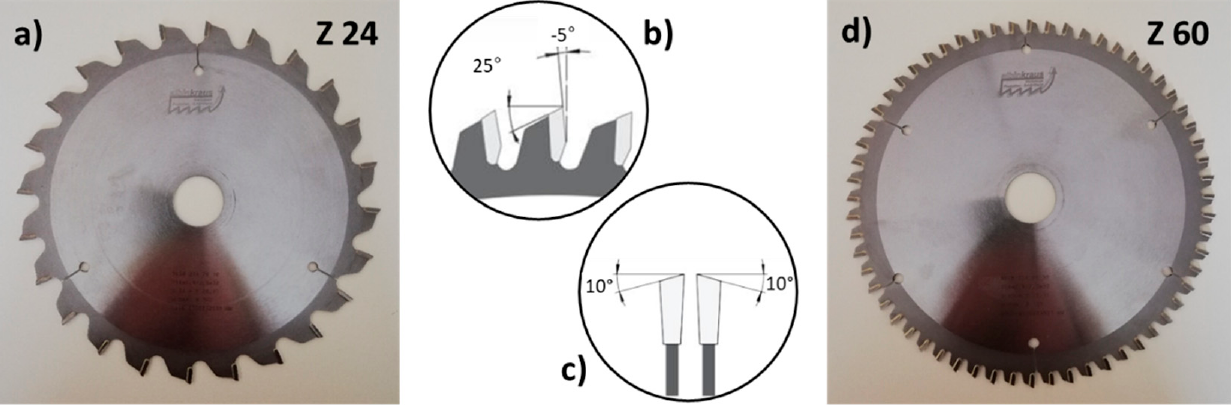
Figure 1. Pictures and sketches showing non-coated 24 teeth (Z24, ( a )) and 60 teeth (Z60, ( d )) saw blades used in this study, including geometry and arrangement of their teeth; alternating cutting edge angle was 10 ◦ ( c ); and teeth had a negative rake angle of − 5 ◦ , and a back clearance angle of 25 ◦ ( b ).